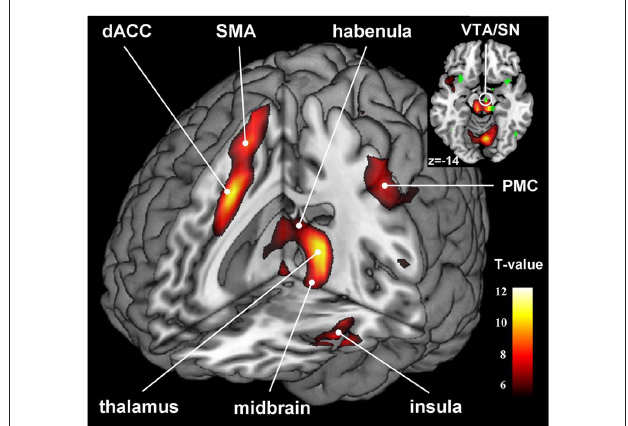
FIgure 1 | error-related activations during a stop signal task: stop error > stop success; p < 0.05, corrected for FWe. dACC, dorsal anterior cingulate cortex; SMA, supplementary motor area; PMC, primary motor cortex. The inset on the top depicts the error-related activations in relation to regions functionally connected to habenula (in green, results from psychophysiological interaction, Figure 2 ).